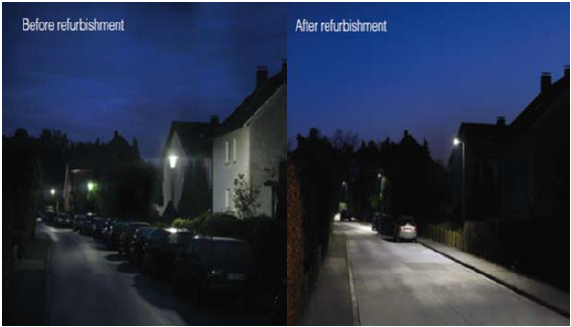
Figure 3. Before and after the refurbishment in a street in Bielefeld, Germany (“Road, paths and squares”, 2014). Apart from the key benefits mentioned above, each case had additional benefits due to the objectives that have been targeted in each individual